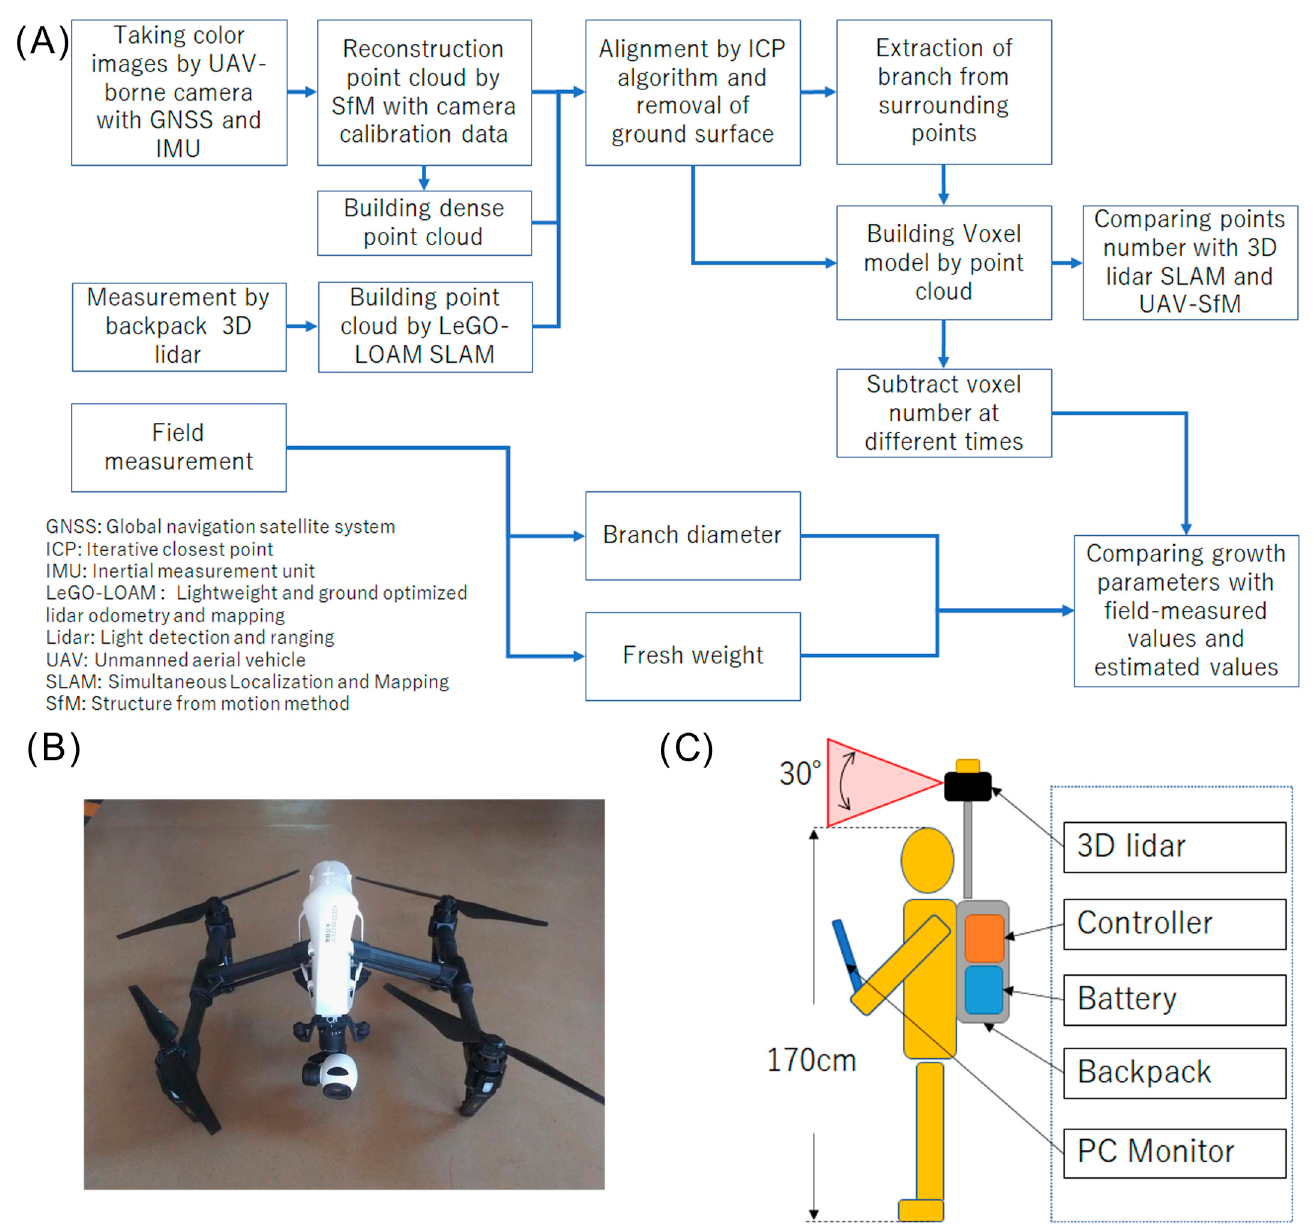
Figure 1. Introduction of the system outline and the sensors: ( A ) system outline; ( B ) DJI Inspire version 2 UAV model; ( C ) 3D lidar system.